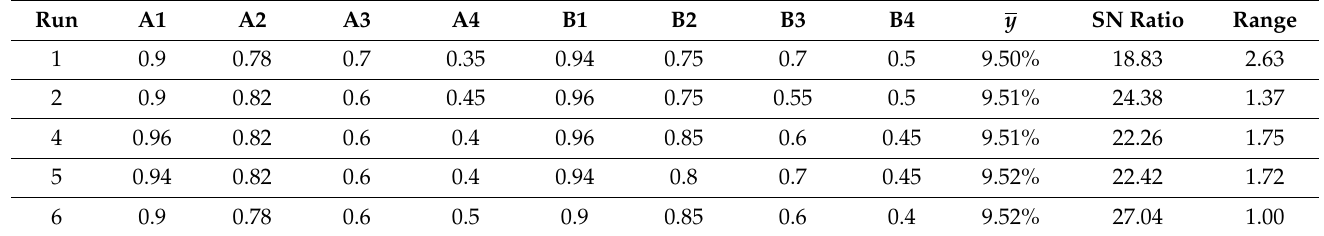
Table 7. Possible combinations of factor levels to obtain a 9.51% target of